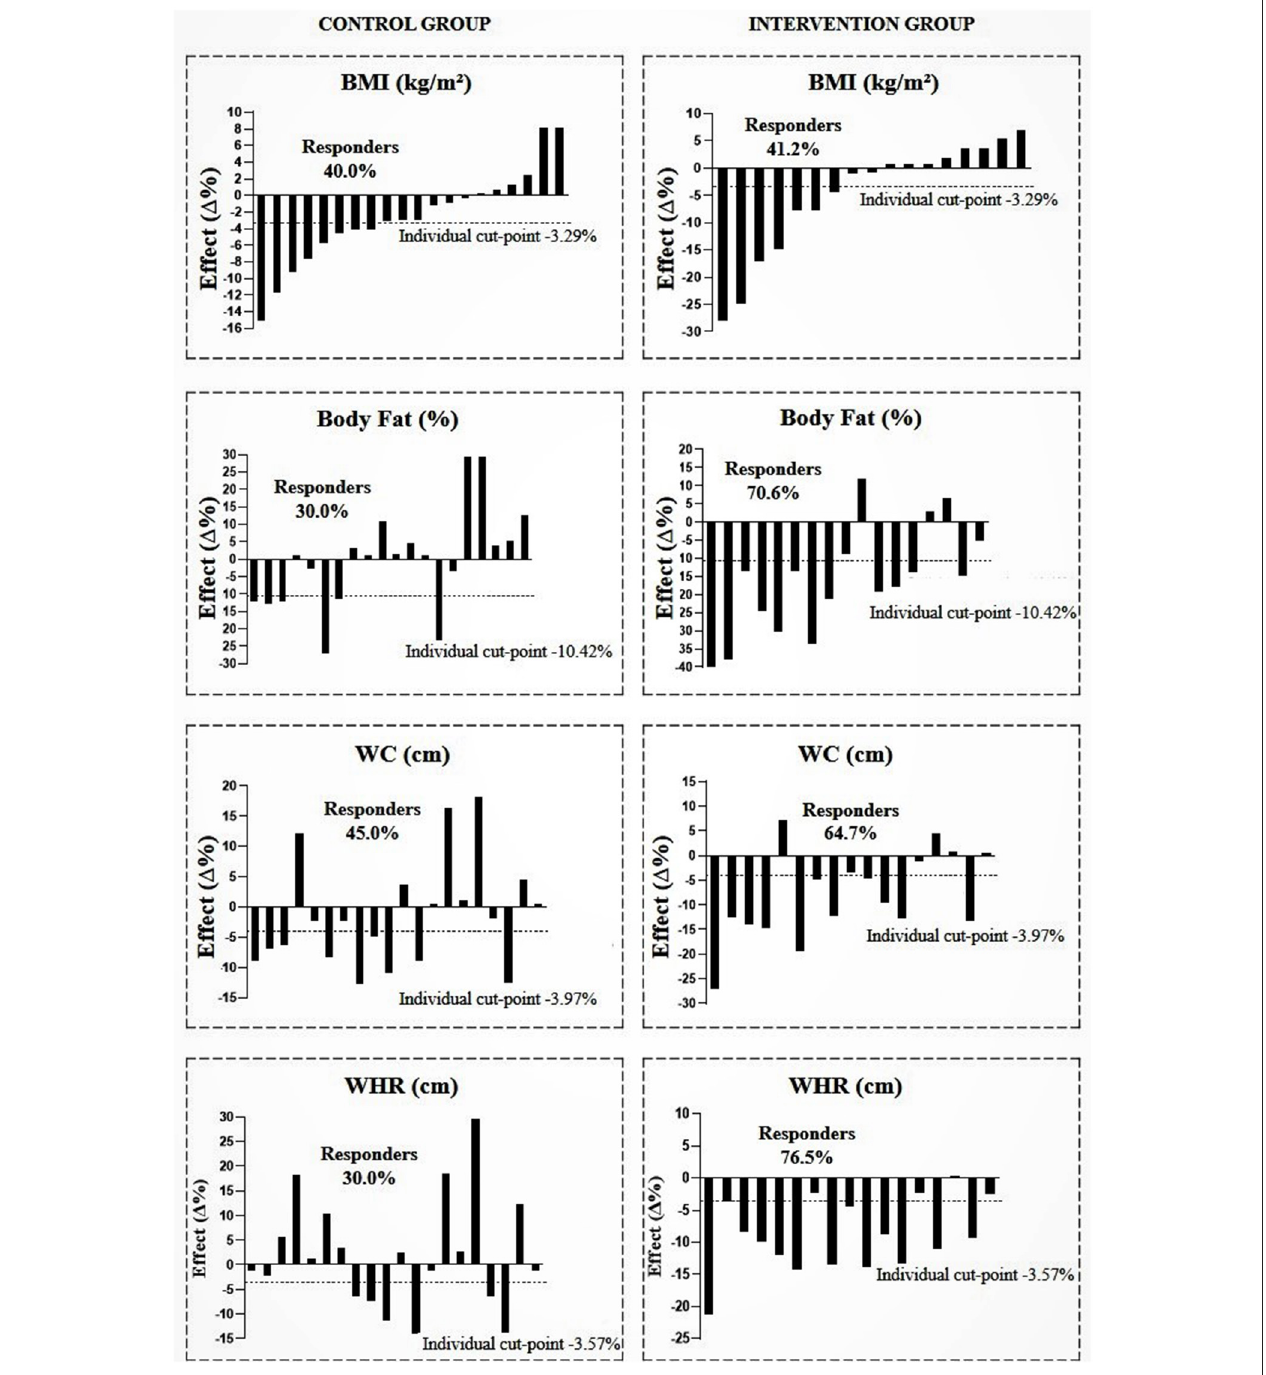
FIGURE 2 | Prevalence of responders in the control and intervention group after multicomponent intervention for body mass index (BMI), body fat, waist circumference (WC), and waist/hip ratio (WHR). CG, n = 20; IG, n = 17. The analyses were adjusted for sex, age, and sexual maturation.